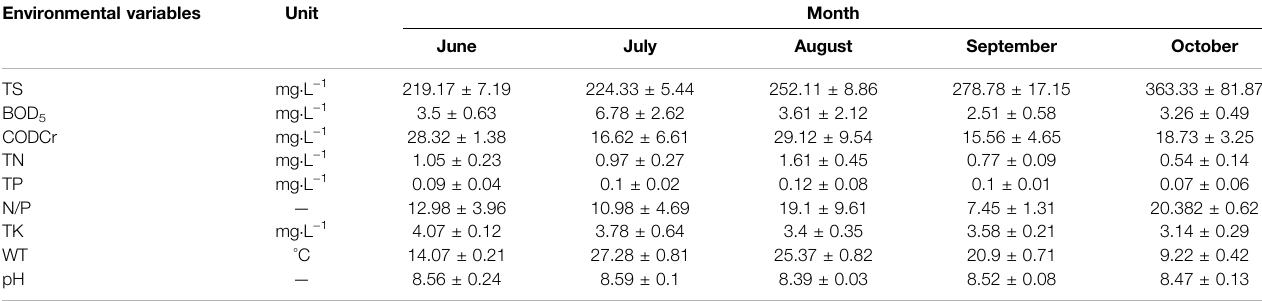
TABLE 1 | Environmental factors in Xinmiao Lake during the investigation